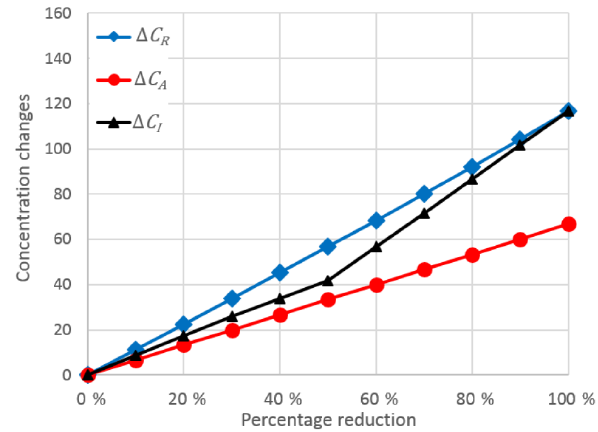
Figure 6. Evolution of the concentration changes resulting from dif- ferent percentage of source abatement (top-down approach) for the three sectors (residential, agricultural and